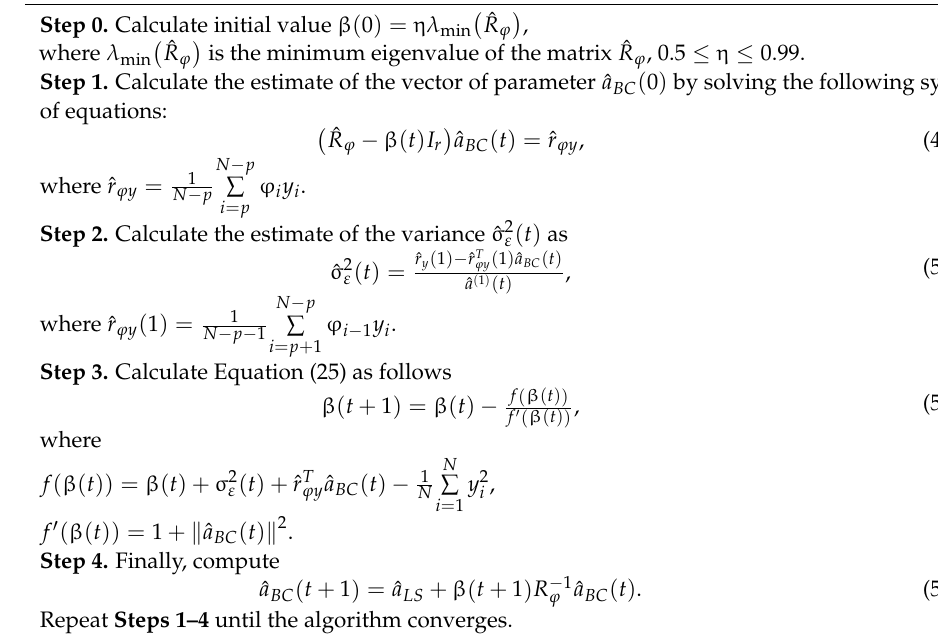
Algorithm 4. The algorithm uses low-order Yule-Walker equations and bias-compensating least squares